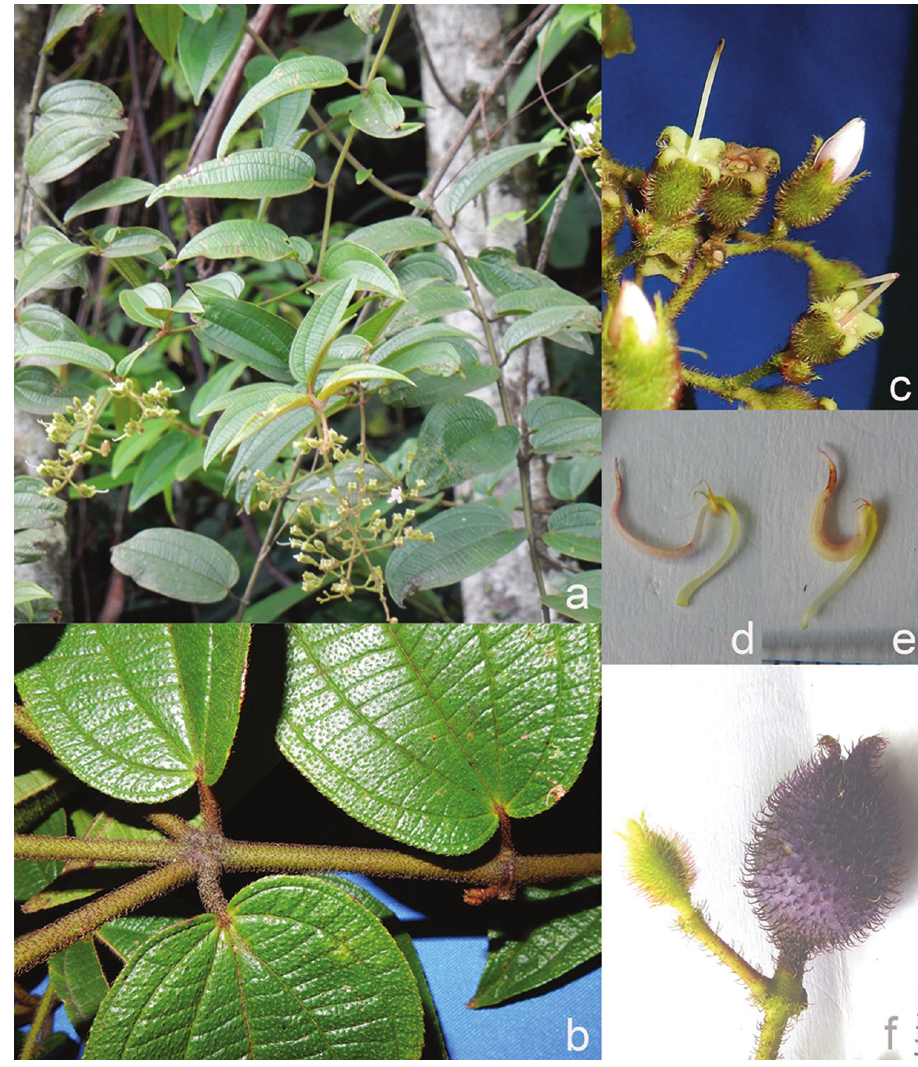
Figure 23. Dissochaeta porphyrocarpa a habit b branchlet c hypanthium d alternipetalous stamen e op- positipetalous stamen f fruit. Photographs by D. Penneys; voucher: Penneys 2486 (WNC). Description. Climbing up to 6 m in height. Branchlets terete, ca. 3 mm in dia meter, sparsely brown stellate-puberulous and densely covered with 1–2 mm long curved purplish-tip bristle hairs; nodes swollen, with an interpetiolar ridge; internodes 6.5–8 cm long. Leaves: petioles terete, 8–15 mm long, densely covered with stellate hairs and curved bristle hairs; blades ovate or elliptic, 9.7–12 × 4.7–7.8 cm, membranous, base subcordate, margin entire, apex acute; nervation with 1 pair of lateral nerves and 1 pair of intramarginal nerves; adaxially scabrid, with hairs and scattered curved bristle